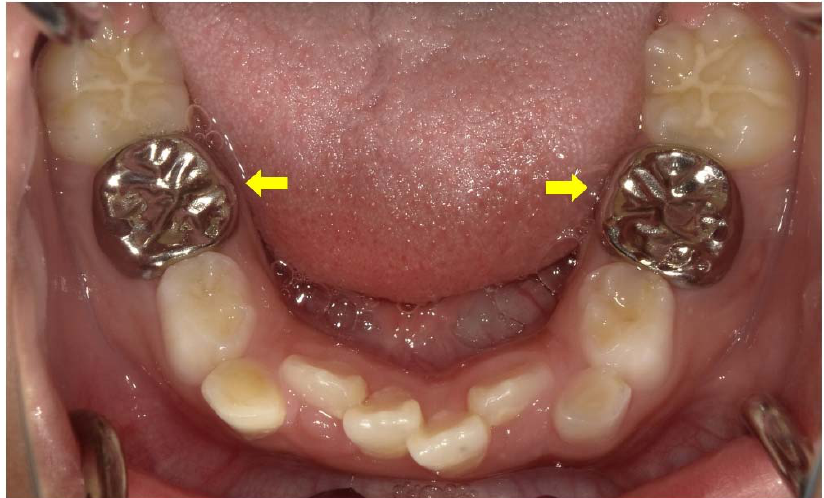
Figure 8. Treatment of a male X-linked hypophosphatemia (XLH) patient aged 8 years 3 months involved full coverage of the primary mandibular second molars with stainless steel crowns (arrows) after root canal treatment associated with a cystic swelling.